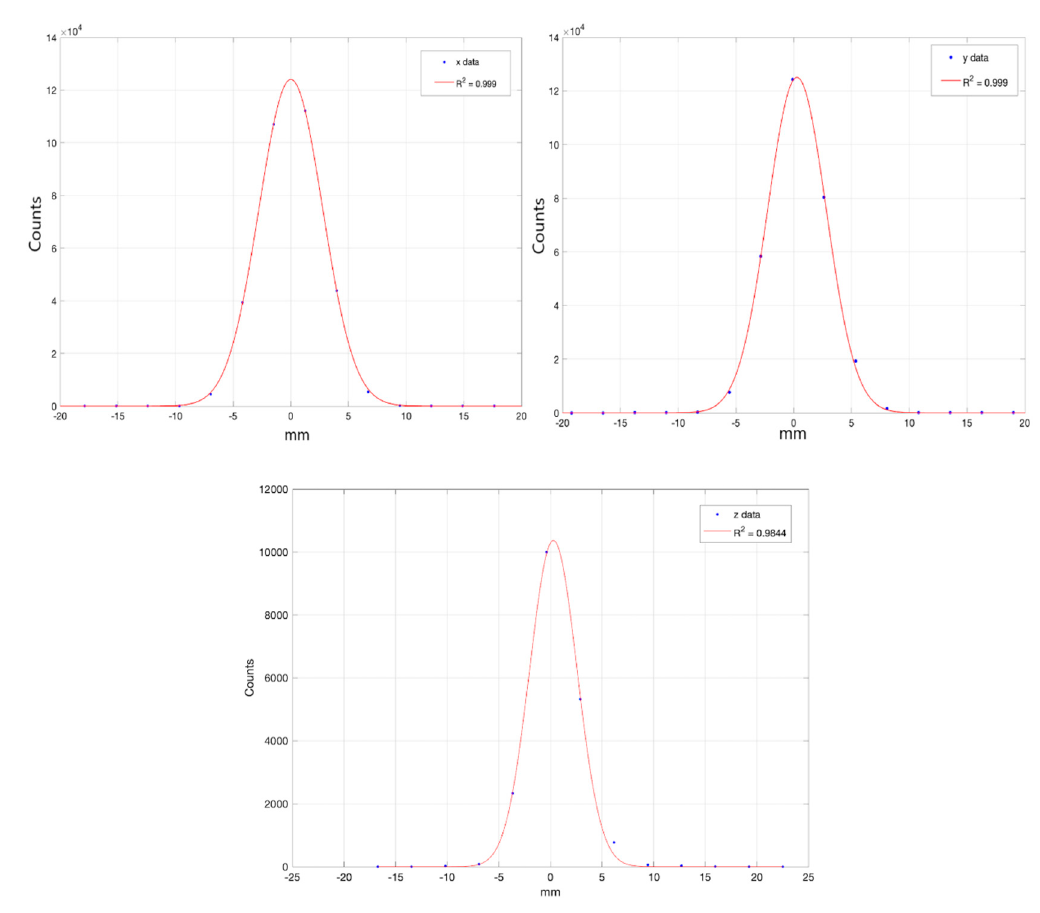
Appl. Sci. 2021 , 11 , x FOR PEER REVIEW Figure 1. Horizontal (x), vertical (y), and axial (z) profiles extracted from the point-like source fitted with a Gaussian function.